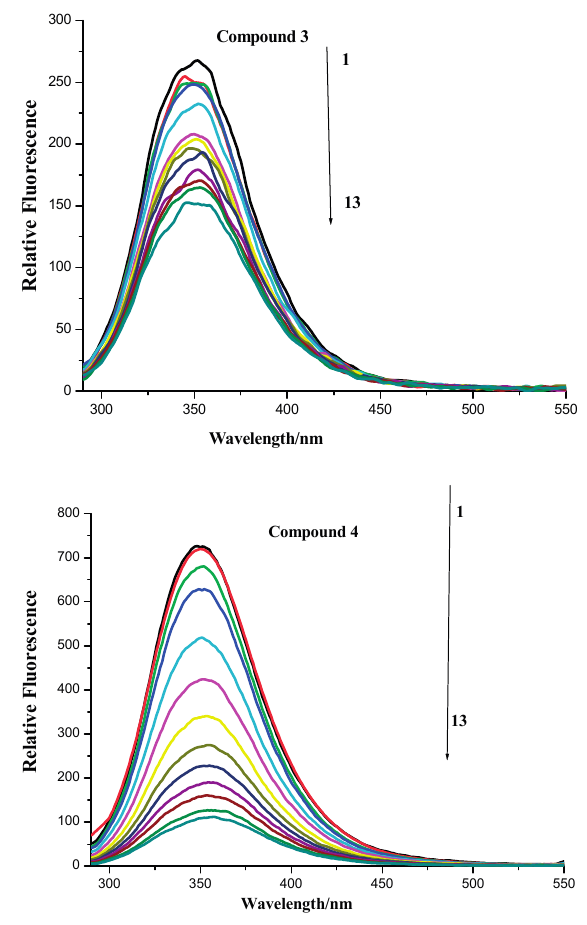
Figure 4. Fluorescence spectroscopy of compounds 1 – 4 and BSA. Numbers 1–13 indicated concentrations of compounds 1 – 4 : 0.0, 0.4 ×10 − 6 , 0.8 × 10 − 6 , 1.2 × 10 − 6 , 2.4 × 10 − 6 , 3.6 × 10 − 6 , 4.8 × 10 − 6 , 6.0 × 10 − 6 , 7.2 × 10 − 6 , 8.4 × 10 − 6 , 9.6 × 10 − 6 , 10.8 × 10 − 6 and 12 × 10 − 6 mol·L − 1 , respectively. BSA concentration applied was 1.04 × 10 − 6 mol·L − 1 . Scan condition: Ex = 280 nm, Em = 290–550 nm; slits of both Ex and Em of compounds 1 – 3 were 5 nm while those of compound 4 were 5 nm and 10 nm, respectively.